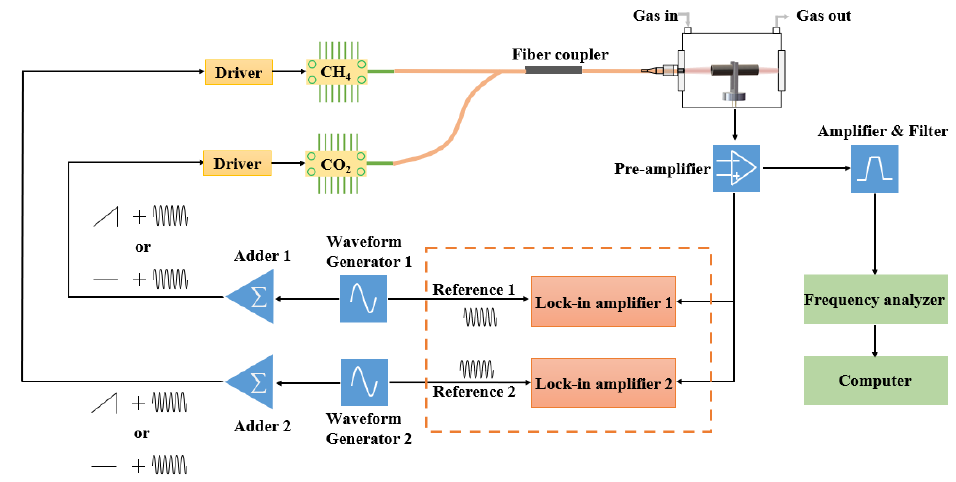
Figure 1. Instrument